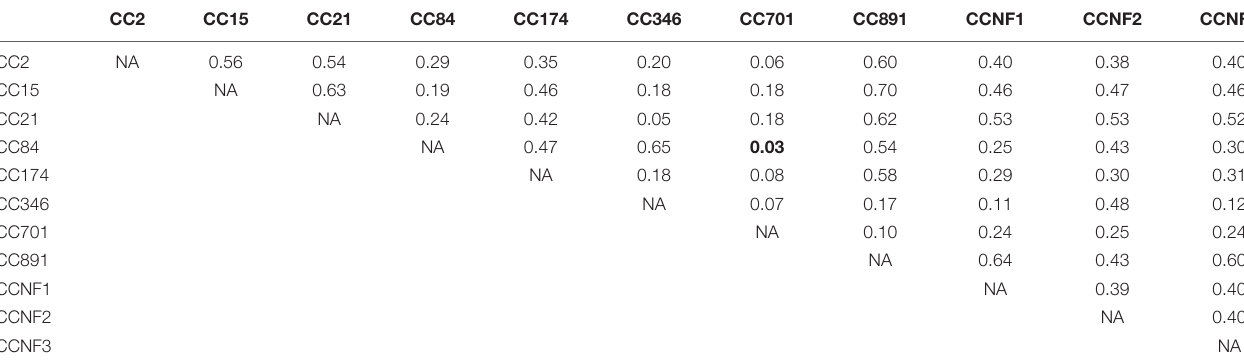
TABLE 3 | Significance level for pairwise comparison of differences in median carriage duration for the 11 spa -CCs.